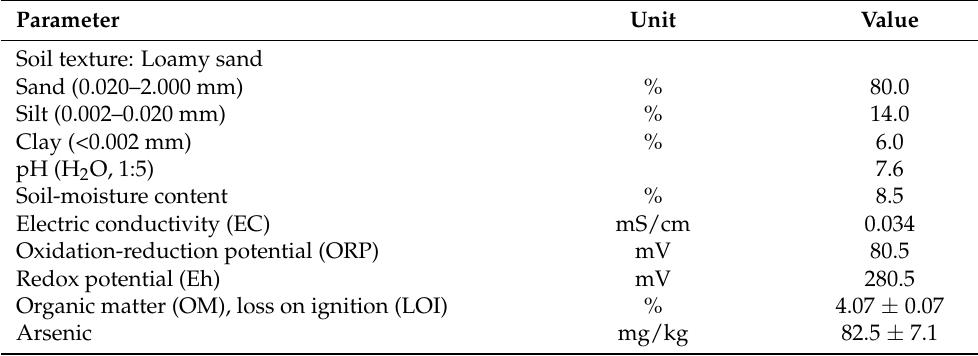
Table 1. Major physicochemical properties of the As-contaminated